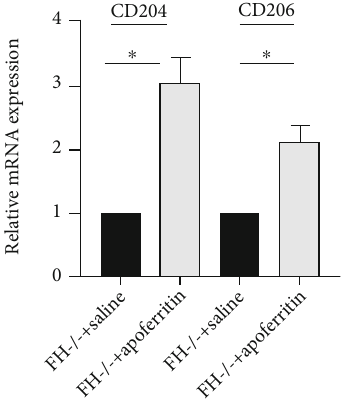
Figure 1: FH alters macrophage marker genes in the kidney of mice with FH-dependent ICGN. Real-time quantitative PCR for CD204 and CD206 using mRNA isolated from the kidneys after 5 weeks of saline or apoferritin. The expression is normalized to GAPDH ( n = 6 /group). ∗ P < 0 : 01 . Graphs depict fold change of genes in apoferritin-treated fh -/- mice ( n = 6 ) compared to fh -/- mice treated with saline ( n = 6